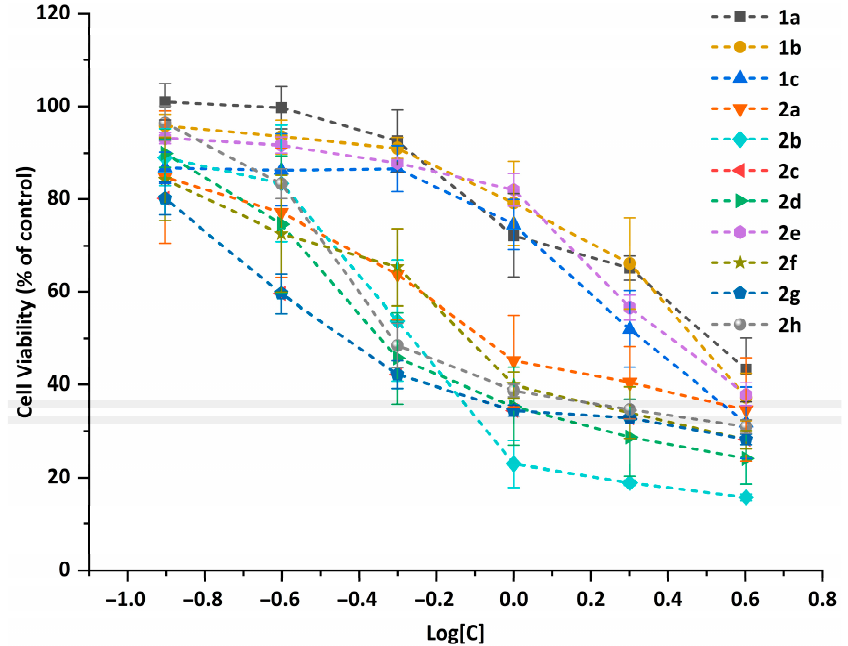
Figure 4. Plots of cell viability vs. the concentration of compounds 1a – 1c and 2a – 2h in different concentrations against Eca-109 cell line. Table 1. IC 50 values ( µ M) from the dose-response assay of compounds 1a – 1c and 2a – 2h and the reference compound cisplatin in the A549, Bel-7402, Eca-109, HeLa and MCF-7 cell lines, after an incubation time of 48